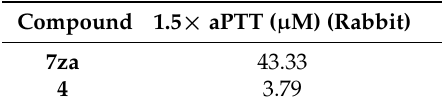
Compound Compound